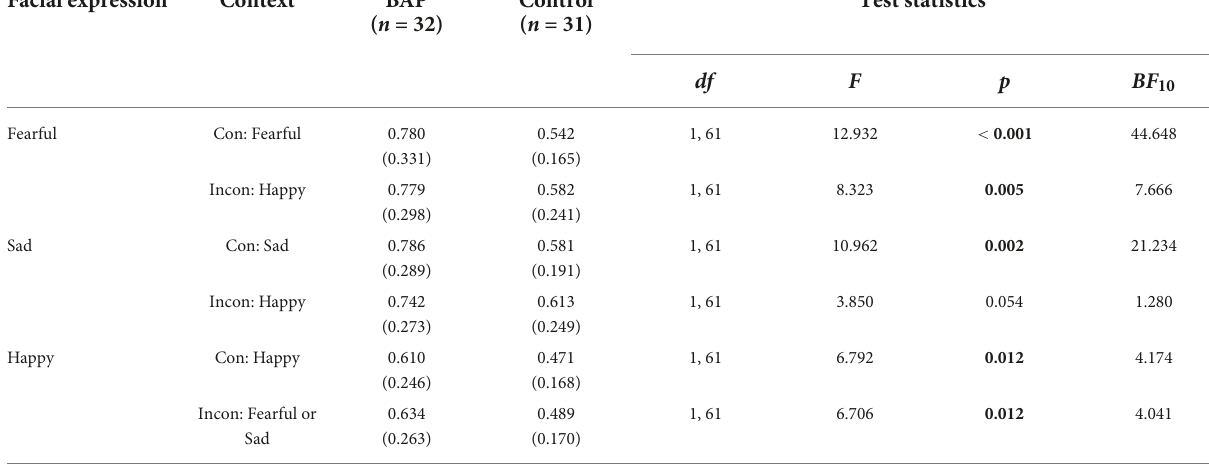
TABLE 2 Mean (SD) of reaction time (in s) under each emotion and congruence condition for the groups. Facial expression